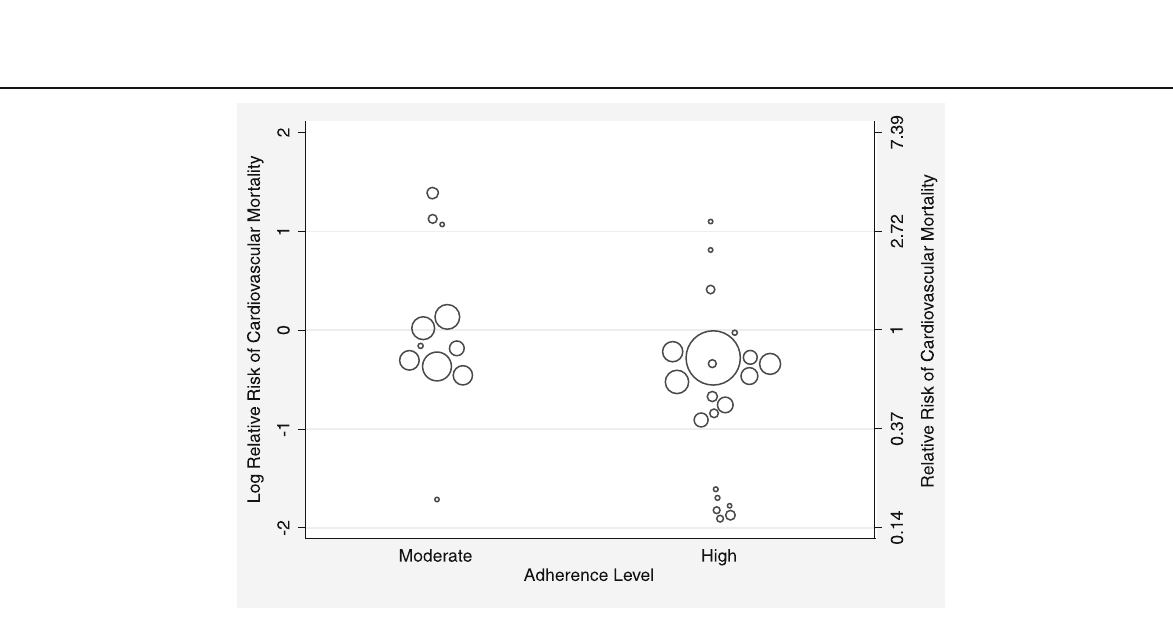
Fig. 3 Relationship between the reported level of exercise intervention adherence and the relative risk of cardiovascular mortality compared to usual care. Each intervention is represented by a circle ; the size of the circle is proportional to the number of participants undertaking that intervention. A log RR of >0 represents an increase in risk and <0 a